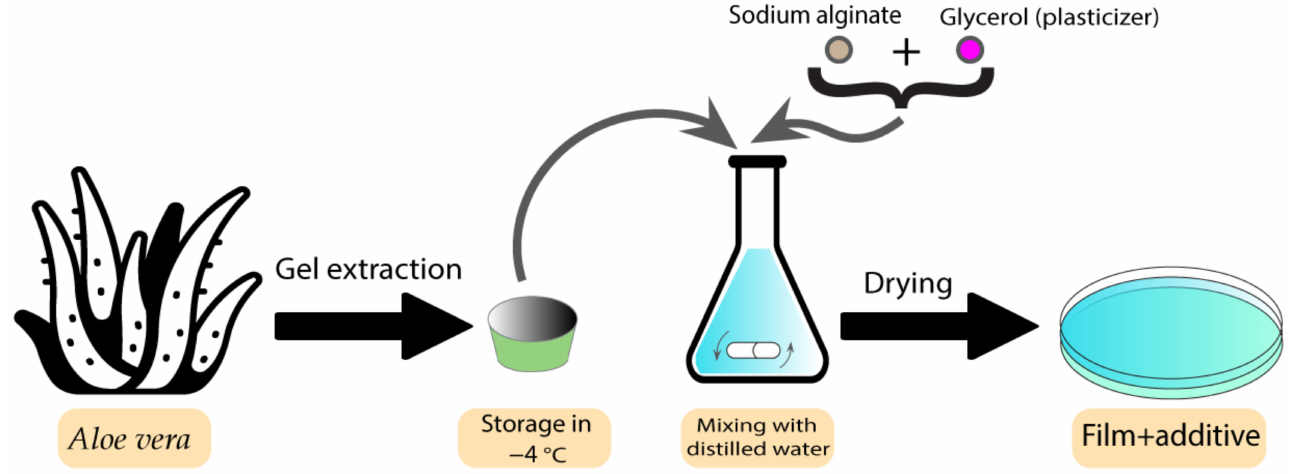
Figure 5. Preparation process of Aloe vera -containing alginate